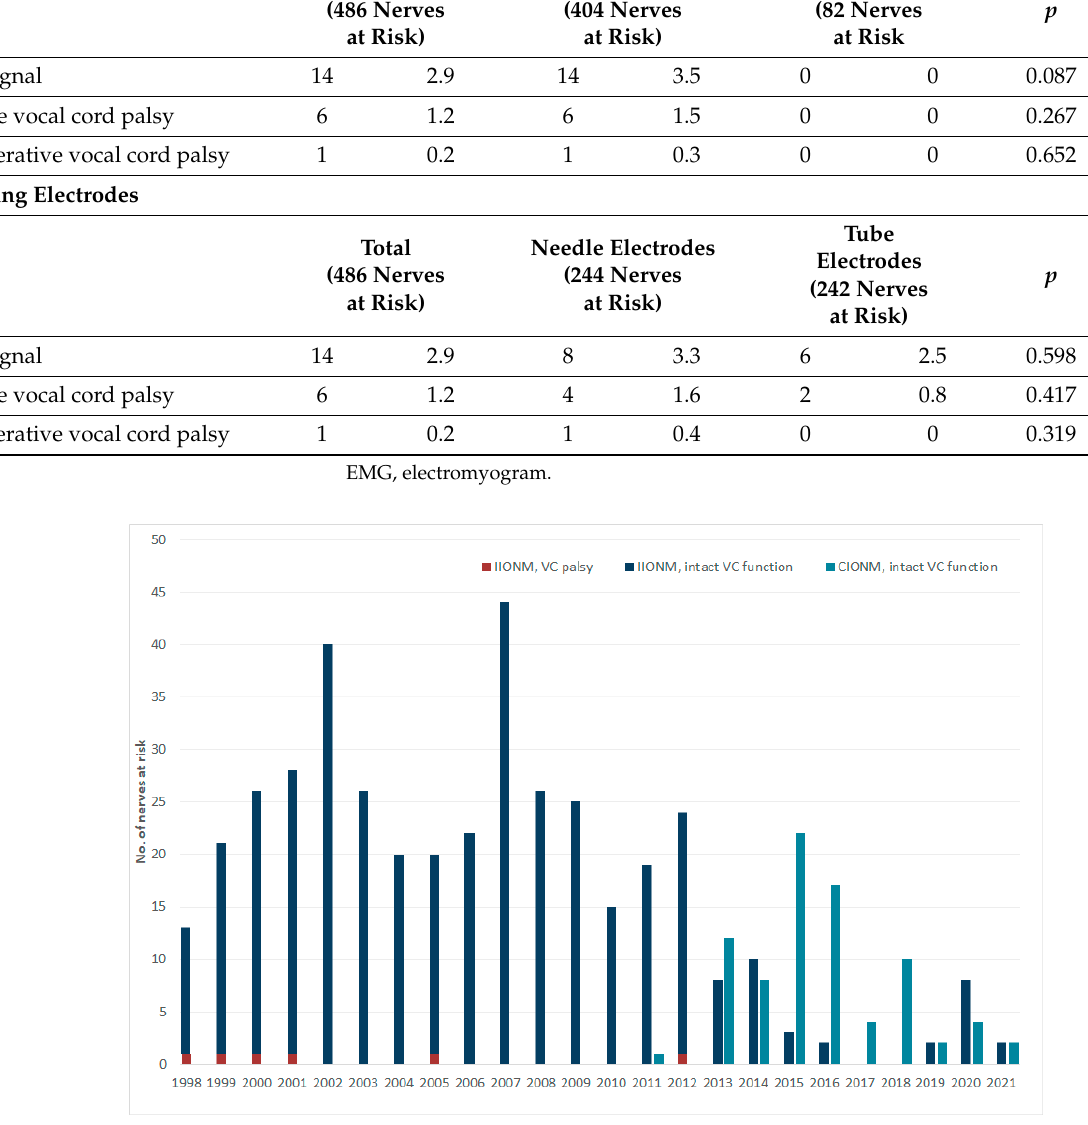
Figure 2. Number of intact vocal cord functions and vocal fold palsies after thyroid surgery per year by intermittent vs. continuous neuromonitoring (IIONM vs. CIONM), January 1998–April 2021. When grouped by type of recording electrodes (Table 3, lower panel), children with needle electrodes sustained loss of the EMG signal (3.3 vs. 2.5%) and early (1.6 vs. 0.8%) and permanent (0.4 vs. 0%) postoperative vocal cord palsies slightly more often than children with tube